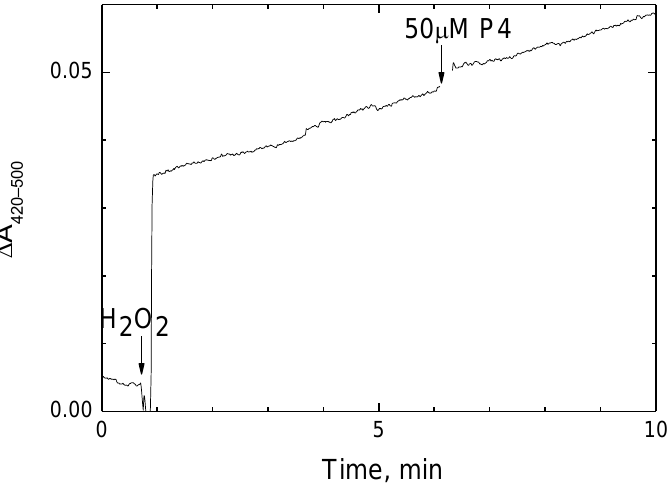
Figure 3. The peroxidase activity of CcO is not affected by P4. Peroxidation of 0.2 mM ferrocyanide (against the background of equimolar ferricyanide) was monitored at 0.6 µ M solubilized CcO. The reaction was triggered by the addition of 4 mM H 2 O 2 (shown by the arrow). The addition of 50 µ M P4 in the course of the experiment is indicated. The initial jump upon H 2 O 2 addition reflects spectral response in the γ -band of heme a 3 upon oxoferryl intermediate formation.